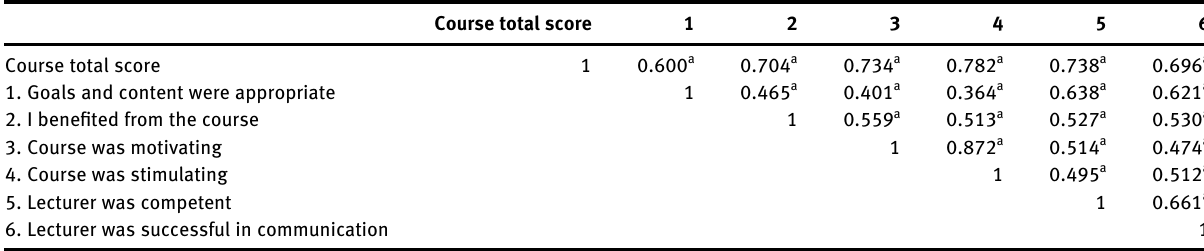
Table  : Correlations between course evaluation domains.